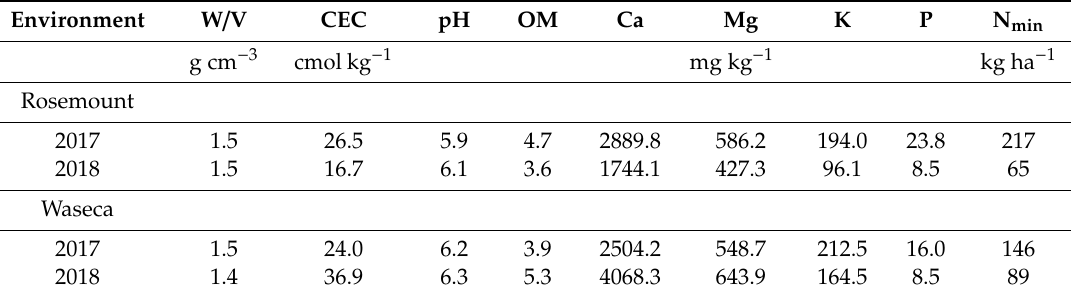
Table 2. Pre-plant soil characteristics of Rosemount and Waseca field sites in 2017 and 2018 from 0–60